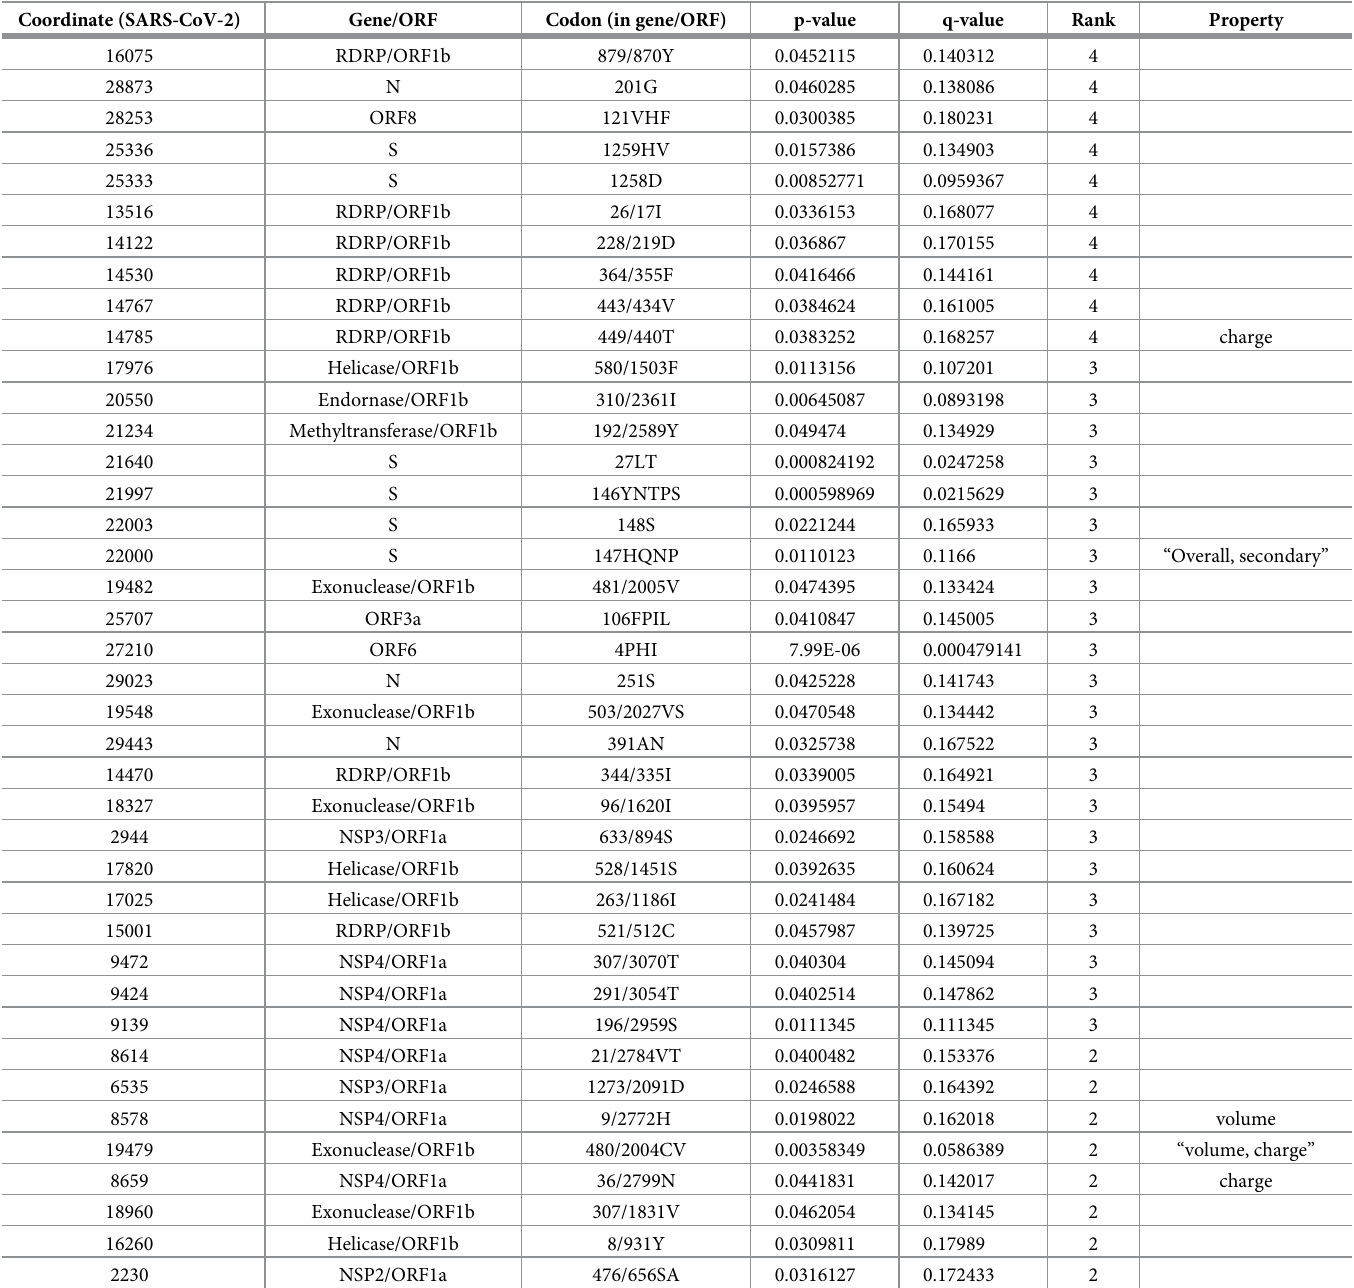
Table 4. A table of high-priority sites in SARS-CoV-2 μ B.1.621